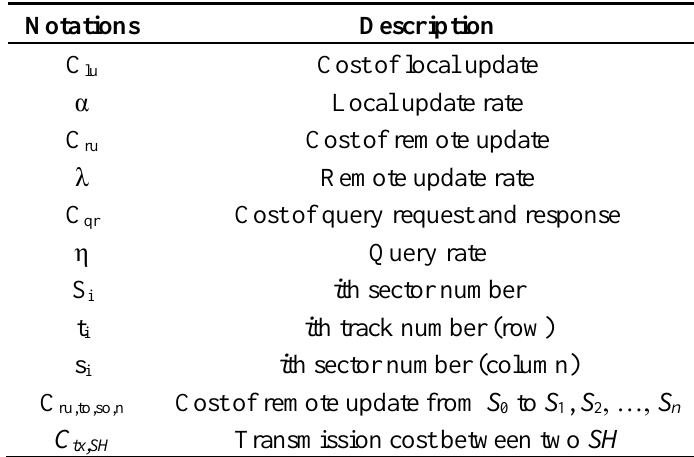
Table 5. Notations used in